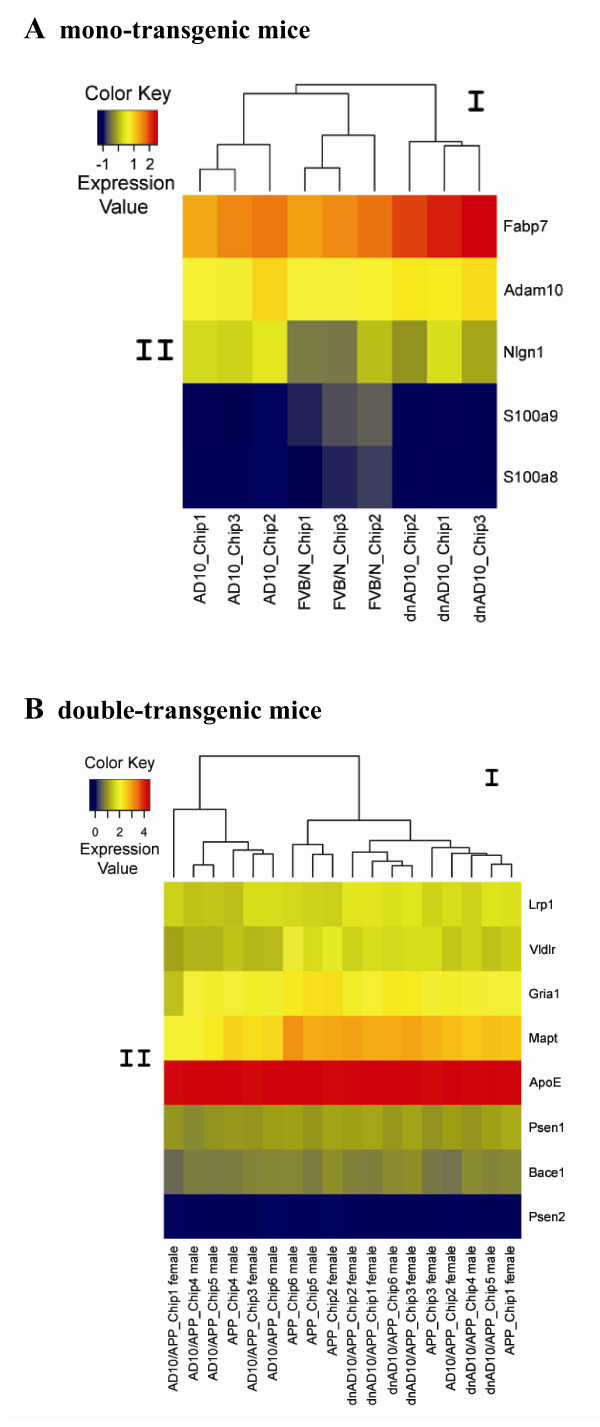
Heat map representing the clustering of genes in mono- and double transgenic mice. A) ADAM10, dnADAM10 and FVB/N mice; B) AD10/APP[V717I], dnAD10/APP[V717I], and APP[V717I] mice. Selected significantly regulated genes on individual chips are shown. The upper graph (I) represents the hierarchical clustering, the colored scales (II) the difference in gene expression. Unsupervised cluster analysis showed that the expression profiles of mono-transgenic mouse genes (A) cluster according to the experimental conditions. In case of double-transgenic mice (B), cluster analysis revealed a more rough agreement in the discrimination of gene expression with experimental groups. The blue (lower expression) to red (higher expression) color scale indicates 2-based logarithms of the mean expression values of the single probes after ChipInspector normalization (Genomatix, Munich, Germany).